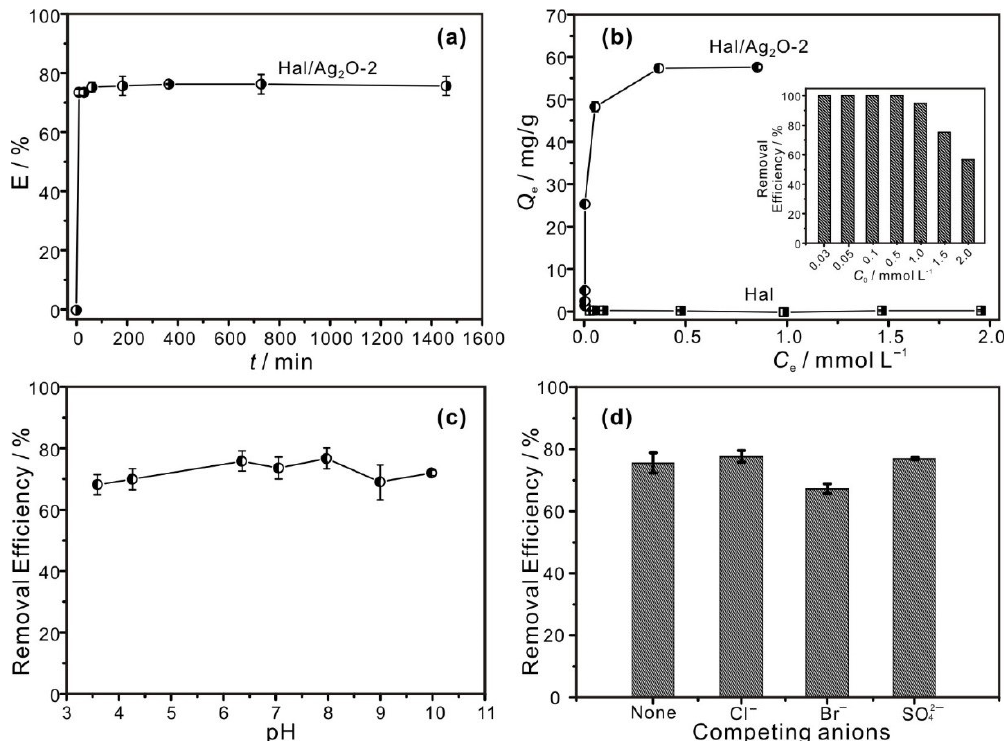
Figure 4. ( a ) Adsorption kinetics of I − on Hal/Ag 2 O-2, ( b ) adsorption isotherms of I − on Hal and Hal/Ag 2 O-2 (inset is the I − removal efficiency from the solutions with different initial concentrations of I − on Hal/Ag 2 O-2), ( c ) the effect of pH on I − adsorption on Hal/Ag 2 O-2, and ( d ) I − removal efficiency of Hal/Ag 2 O-2 under competitive adsorption conditions.